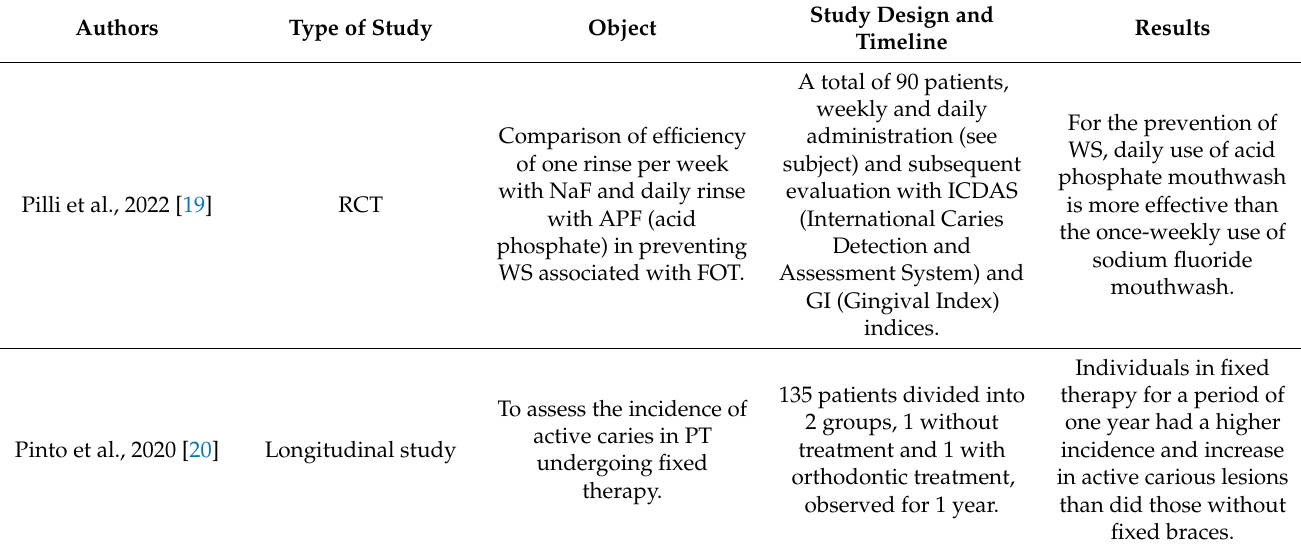
Table 2. Studies included in the systematic